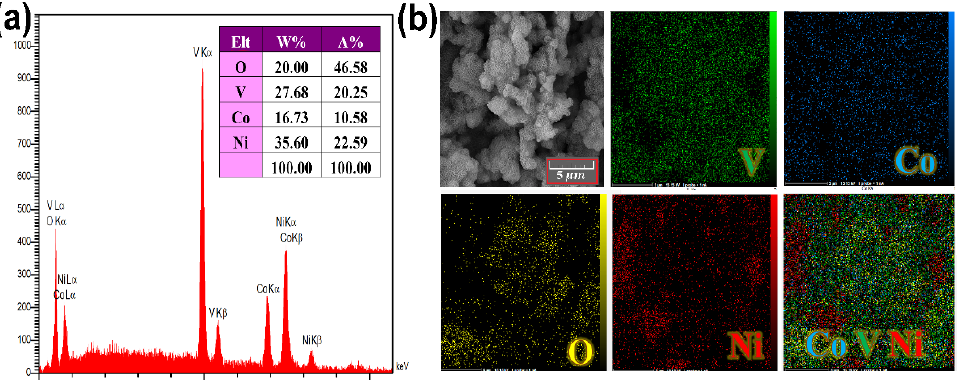
Figure 4. ( a ) EDX spectrum, and ( b ) elemental mapping images of constituent elements of the petal- like Co x NiV y O z coated on Ni foam substrate. V, Co, Ni, and O elements are present on the electrode surface with relative atomic concentrations listed in the inserted table.